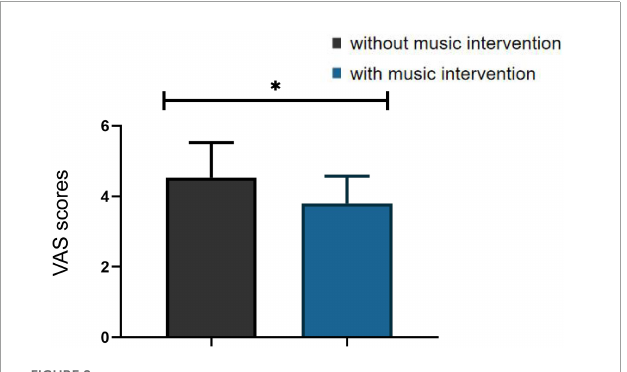
FIGURE8 Visual analogue scales (VAS) scores in the condition with and without musical intervention ( ∗ p <